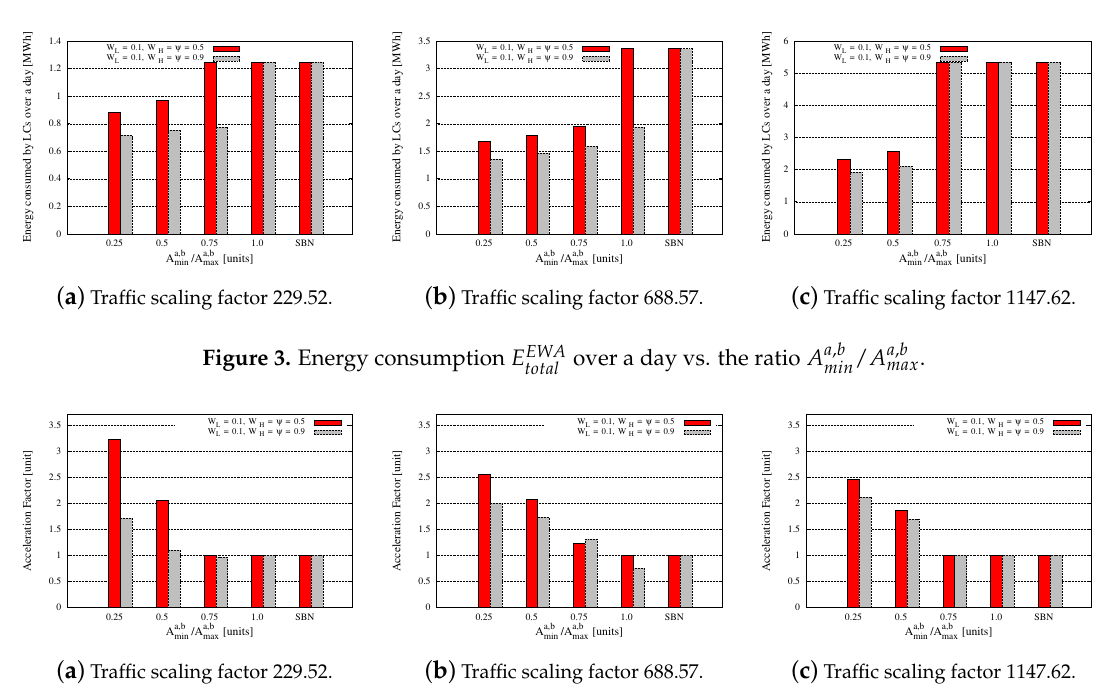
( a ) Traffic scaling factor 229.52. ( b ) Traffic scaling factor 688.57. ( c ) Traffic scaling factor 1147.62. Figure 4. AF avg with AF sleep = 0.5 units and χ = 0.5 h/cycle after 14 days vs. the ratio A a , b / A a , b max . min In the next part, we vary the length of the set of low-demand time periods T low in the range 0–7.5 h. Energy consumption E EWA and AF avg are shown in Figures 5 and 6, respectively. As expected, the total longer the period when traffic is low, the lower the energy consumption. This can be observed for all the three scaling factors and the two EWA settings (with lower energy consumption achieved with the more liberal EWA setting). The length of the low-demand periods does not affect AF avg as shown in Figure 6. This is due to the fact that traffic increases and decreases only once during the set of all considered time periods T (see Figure 1) even for | T low | equal to 0. However, AF avg values are consistently higher than 1. It is interesting to note that the AF avg values are higher for the more conservative EWA setting. This is due to the fact that the targeted overprovisioning ( ψ = 0.5) leaves lower lightpath capacity for transporting traffic (with no unexpected variations). Given the same traffic and lightpath capacity C as input, the lightpath (and corresponding LCs) have to be more frequently activated/deactivated when ψ = W H = 50% (corresponding to usable lightpath capacity 0.5 · 40 Gbps)